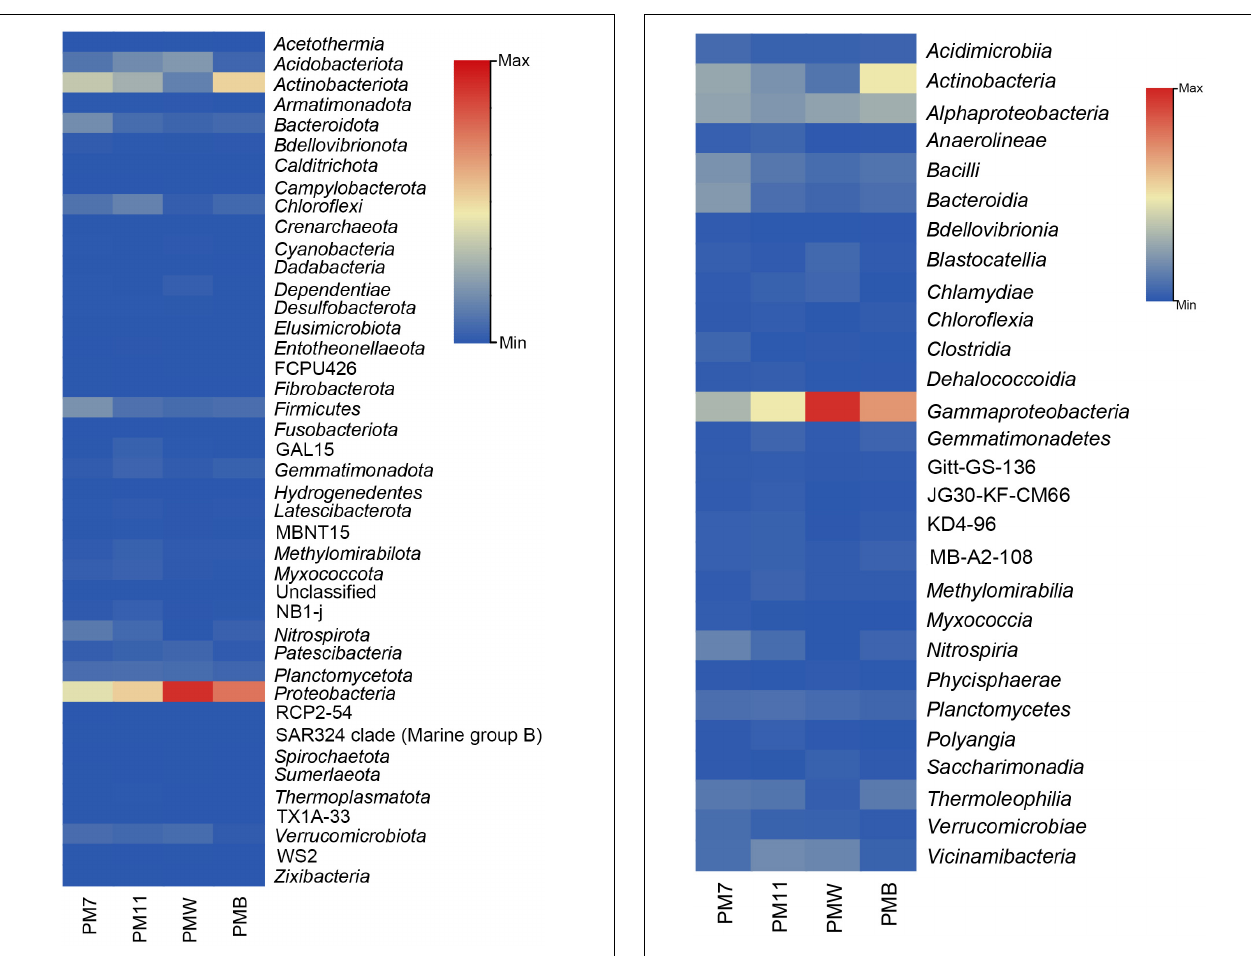
FIGURE 2 | Heatmap of the relative abundance of the different bacterial phyla in the four analyzed samples of Muierilor Cave.